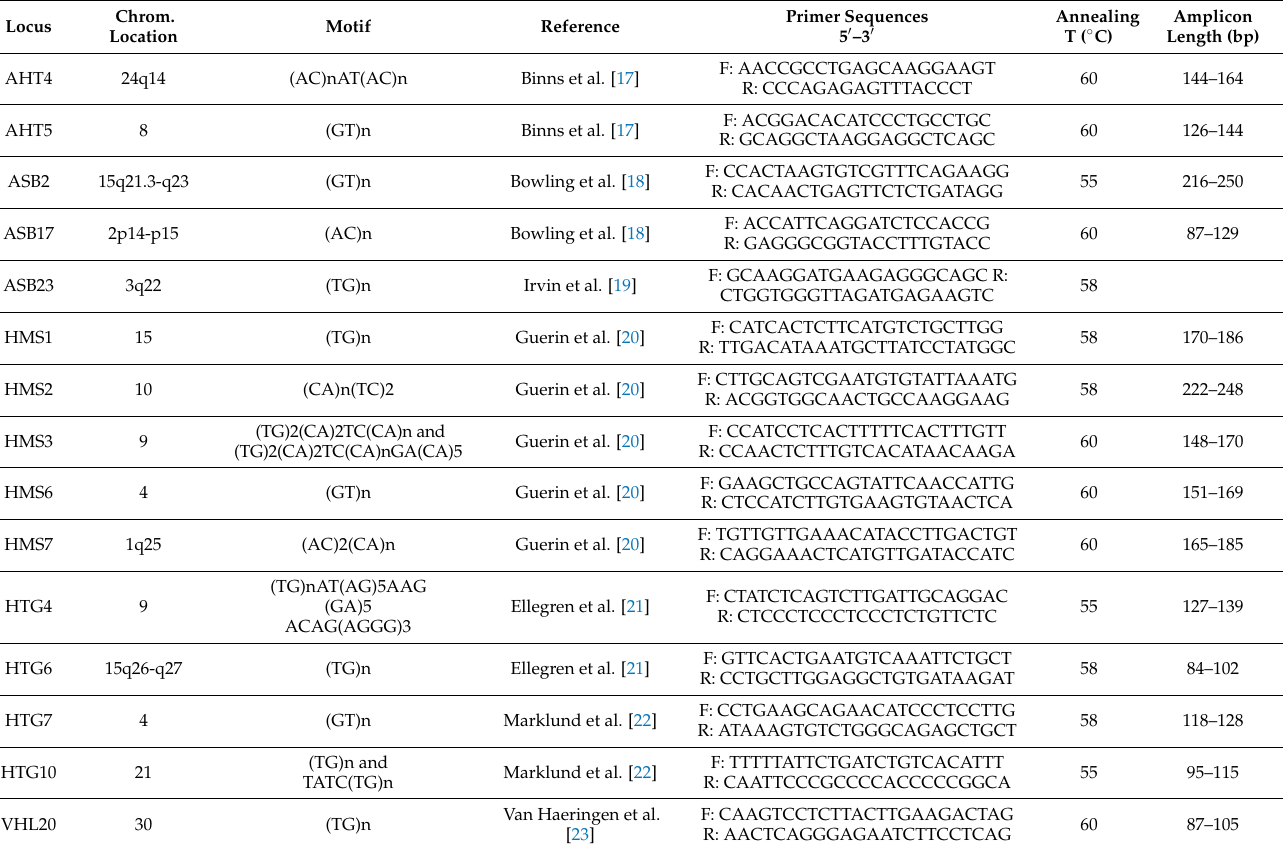
Table 1. Horse STR information used in the study: Locus name, chromosomal location, repeat structure and repeat sequence, reference, primer sequences, and the size ranges of the